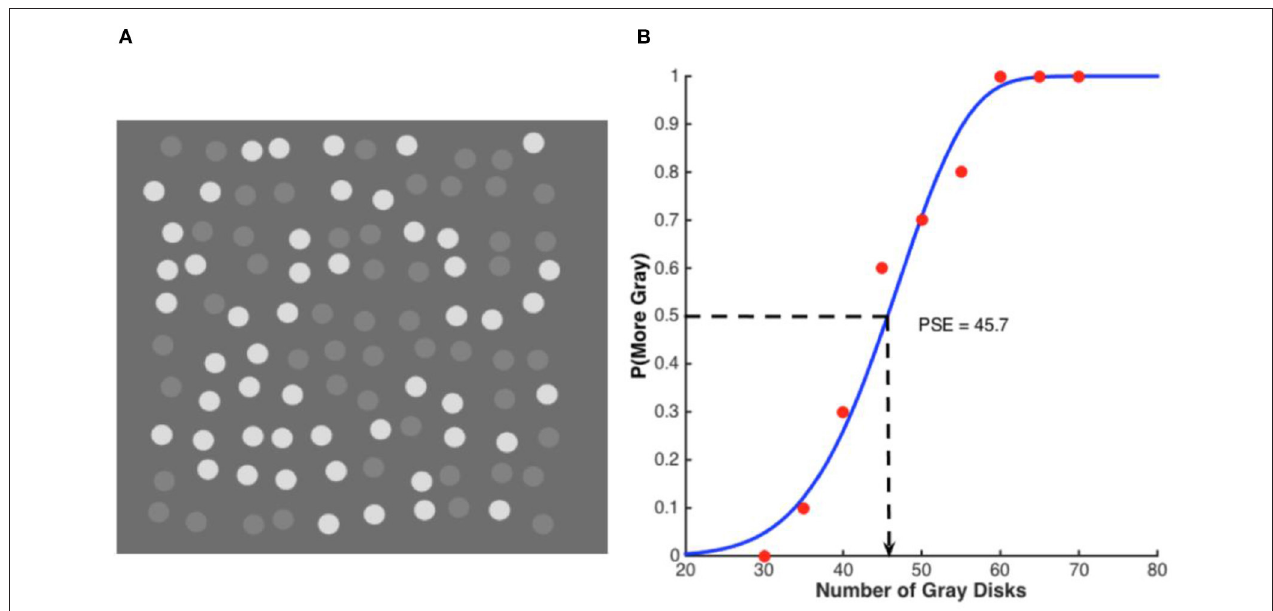
FIGURE 1 | Example stimulus and psychometric function. (A) An example disk array in a discrimination task. The standard disk set (here, the white ones) had a fixed numerosity of 50 while the numerosity of the comparison disk set (here, gray) varied in a range of 30–70. In this example, both sets had a numerosity of 50. (B) An example psychometric function from one subject plots the probability of the gray disks being chosen as more numerous against their physical numerosity. The dots represent one subject’s data and the curve the best-fitting Weibull function. The PSE, 45.7, indicates how many gray disks matched 50 white disks in perceived numerosity, implying that the white disks were under-estimated relative to the gray